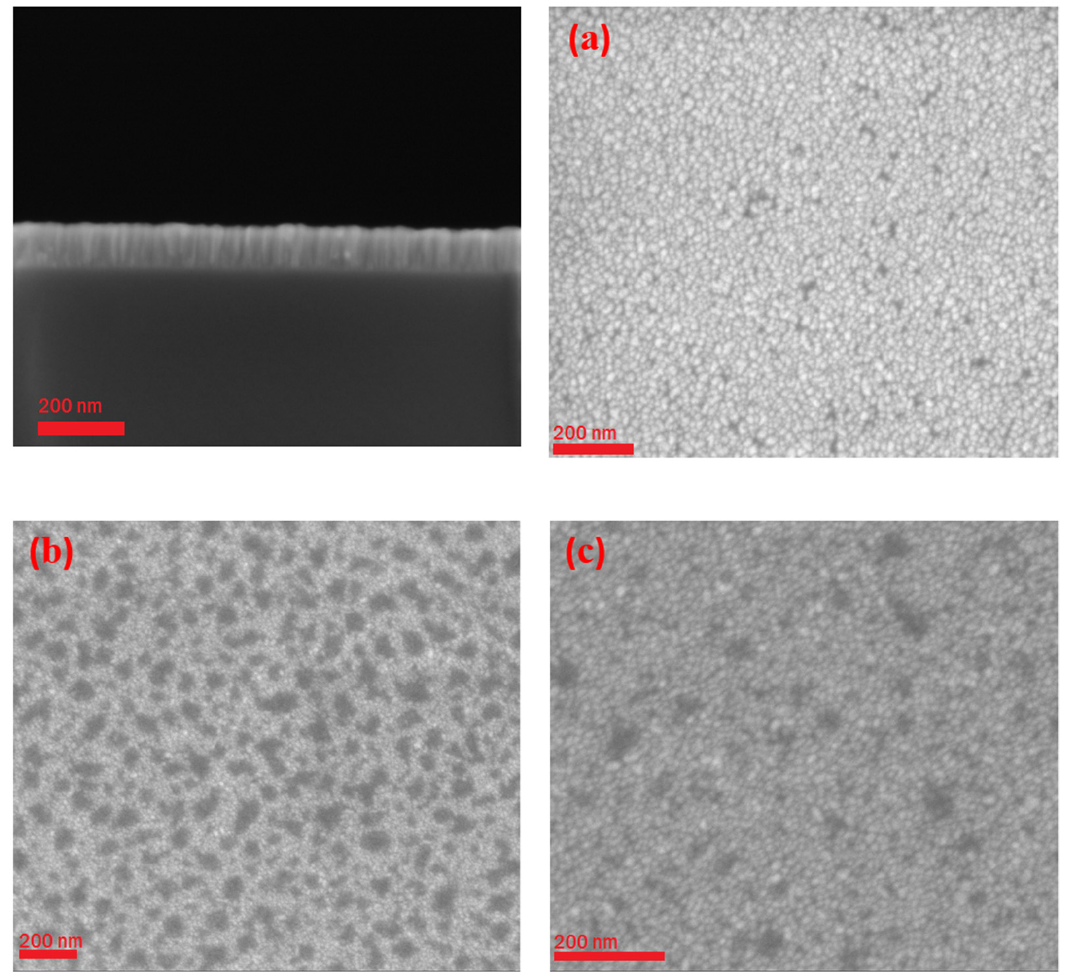
Figure 5. Cross sectional view of ZO thin film deposited in SiO 2 and SEM photos for the ( a ) undoped ZO and Fe doped ZO at DC deposited power ( b ) 3 W and ( c ) 5 W.